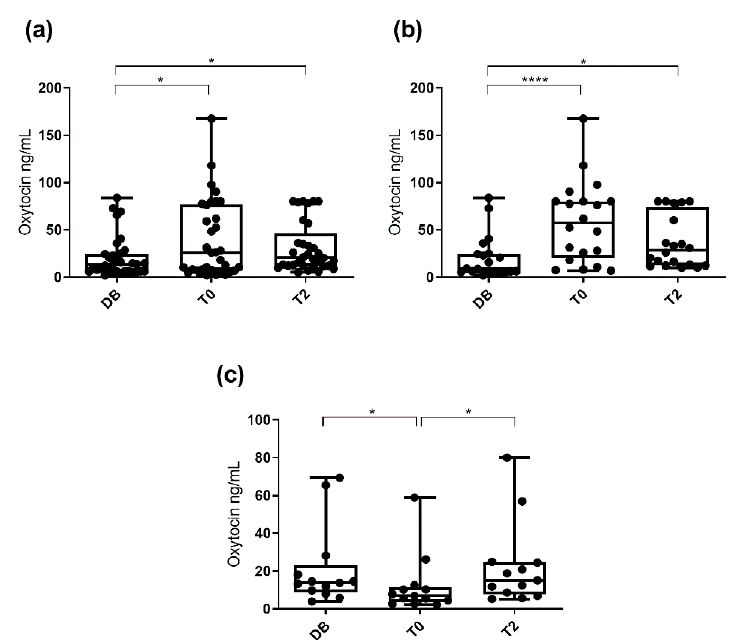
Figure 4. Changes in salivary oxytocin concentrations measured with AlphaLISA polyclonal assay at di ff erent times: the day before ejaculate collection (DB), immediately after starting the ejaculation (T0) and two hours after ejaculation (T2). Data for all 33 boars ( a ), data for the 20 boars showing increased oxytocin concentration at ejaculation time ( b ), and data for the 13 boars that did not show increased oxytocin concentrations at ejaculation time ( c ). The plots show medians (line within box), 25th and 75th percentiles (boxes), min and max values (whiskers) and individual data points. Asterisks indicate di ff erences between times (**** p ≤ 0.0001; * p ≤ 0.05).